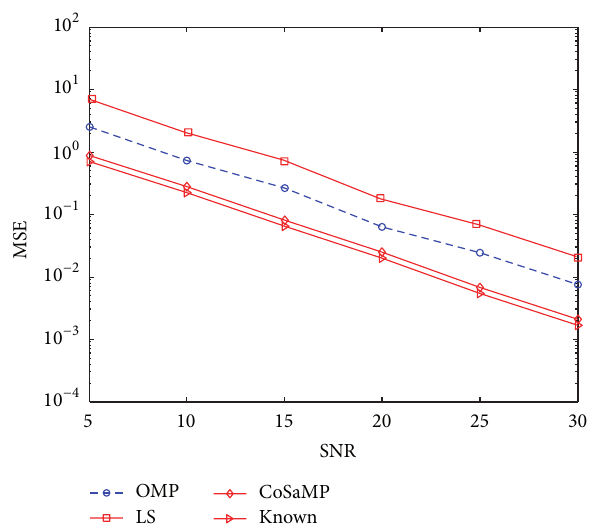
Figure 4: MSE performance of channel estimation at T 1 for when channel impulse responses h 𝑖 𝑟,𝑚 are sparse enough ( 𝑑 = 2 ).